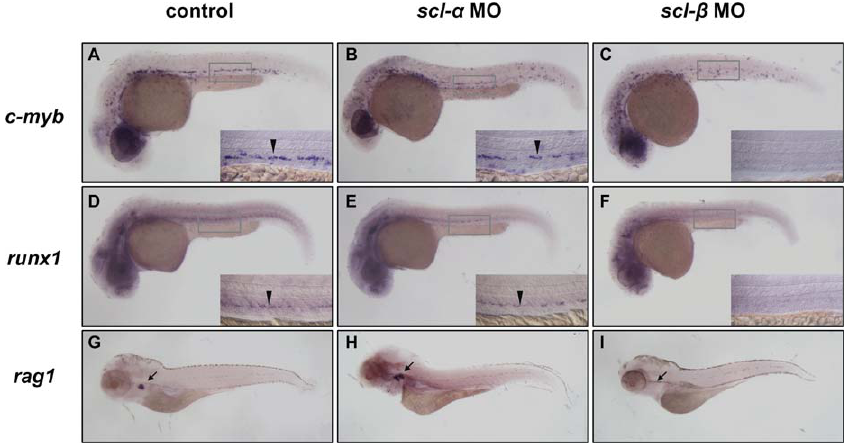
Figure 6. Specification of Definitive Hematopoietic Stem Cells Requires scl- b but Not scl- a (A–F) WISH of definitive hematopoietic stem cell markers c-myb (A–C) and runx1 (D–F). Expression of c-myb and runx1 in the ventral wall of DA was markedly reduced in 30-hpf scl- b morphants (C and F) but not in 30-hpf control embryos (A and D) or scl- a morphants (B and E). Insets are high- magnification (20 3 ) views of the ventral wall of DA. The arrowheads indicate the definitive hematopoietic stem cells along the ventral wall of DA. (G–I) WISH of T cell marker rag1 . rag1 expression in thymic T cells was abolished in 5-dpf scl- b morphants (I) but not in control embryos (G) and scl- a morphants (H). Arrows indicate the thymus region. In all panels, embryos are in lateral view with anterior to the left.